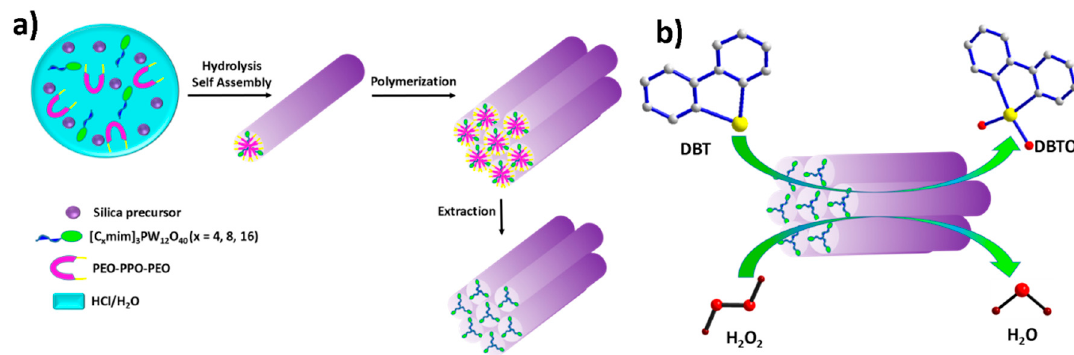
Figure 6. ( a ) Fabrication of ordered mesoporous silica encapsulating polyoxometalates (POMs)-based ionic liquids (IL); ( b ) possible desulfurization mechanism for the oxidation of DBT to DBTO 2 with concomitant transformation of hydrogen peroxide to water [125].